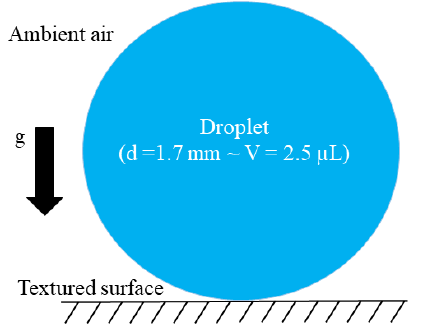
Fig. 3. Schematic diagram of falling droplet in contact with surface.